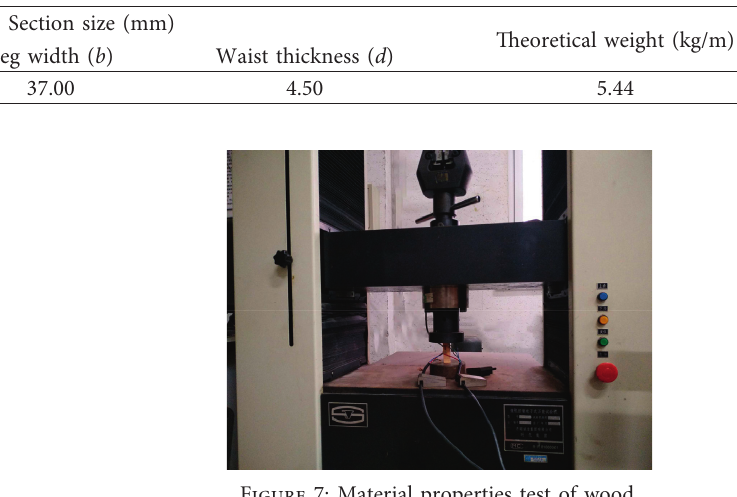
Figure 7: Material properties test of